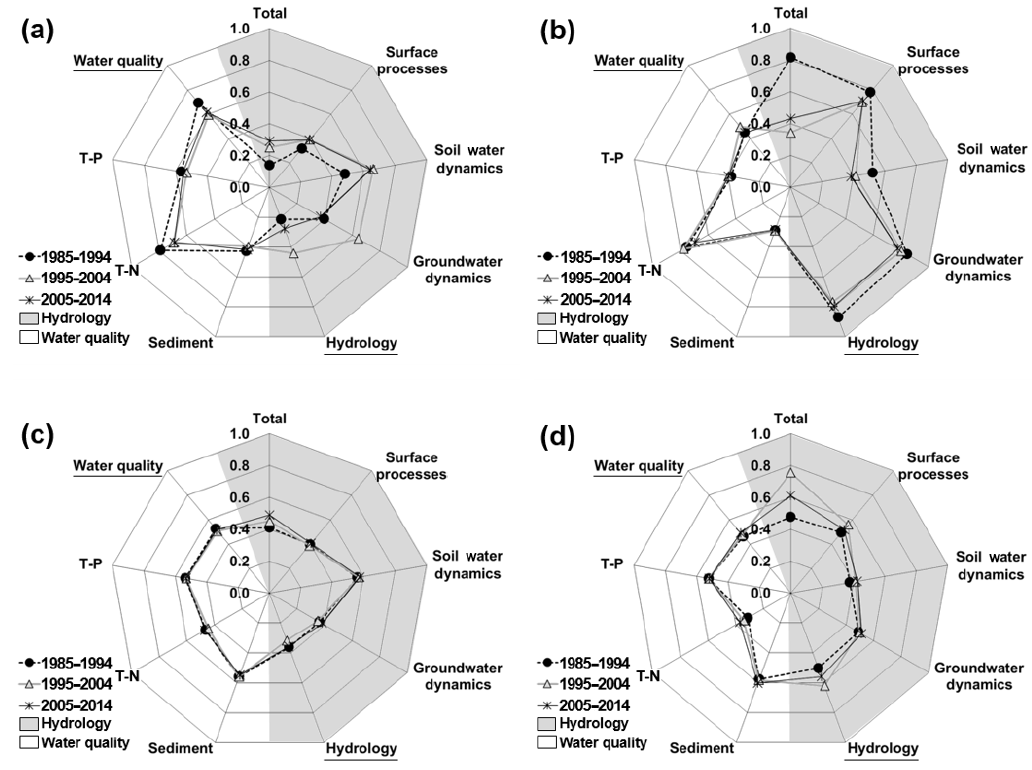
Figure 9. Change in hydrology and water quality for the (a) A (SYD watershed), (b) B (CJD watershed), (c) C (PDD watershed), and (d) D (lower watershed) test areas for three 10-year